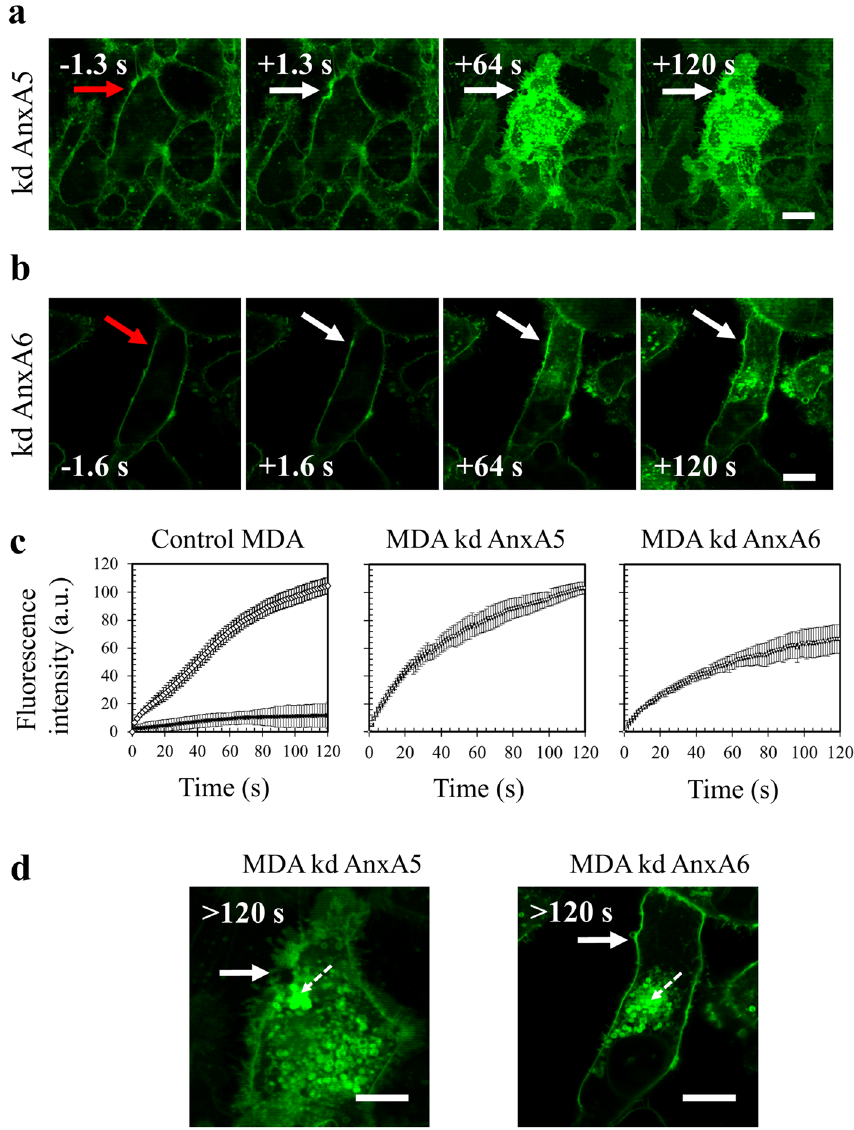
Figure 7. Responses of AnxA5-deficient or AnxA6-deficient MDA-MB-231 cells to a membrane damage by laser ablation. Sequence of representative images showing the response of an AnxA5-deficient ( a ) or an AnxA6-deficient MDA-MB-231 ( b ) cell after membrane damage performed by laser irradiation in the presence of FM1-43 (green) is presented. Cells were treated and presented as described in the legend of Fig. 4. Scale bar: 10 μm. ( c ) Kinetic data represent the FM1–43 fluorescence intensity integrated over whole cell sections, averaged for about 60 cells (±SD) from five independent experiments (see also Supplementary table 2). The response of control (control MDA), AnxA5-deficient (MDA kd AnxA5) and AnxA6-deficient (MDA kd AnxA6) MDA-MB-231 cells are presented. Control cells were MDA-MB-231 cells transduced with SCshRNA-containing lentiviral particles. For MDA kd AnxA5 and MDA kd AnxA6 a continuous and large increase of the fluorescence intensity was observed, indicating the absence of membrane resealing. ( d ) Zoomed and unsaturated images of kd AnxA5 and kd AnxA6 cells presented in a and b 120 s after membrane injury, respectively. Large filled and small dashed white arrows point out the wound site and the lipid material accumulating inside the cell after membrane injury, respectively. Scale bar: 10